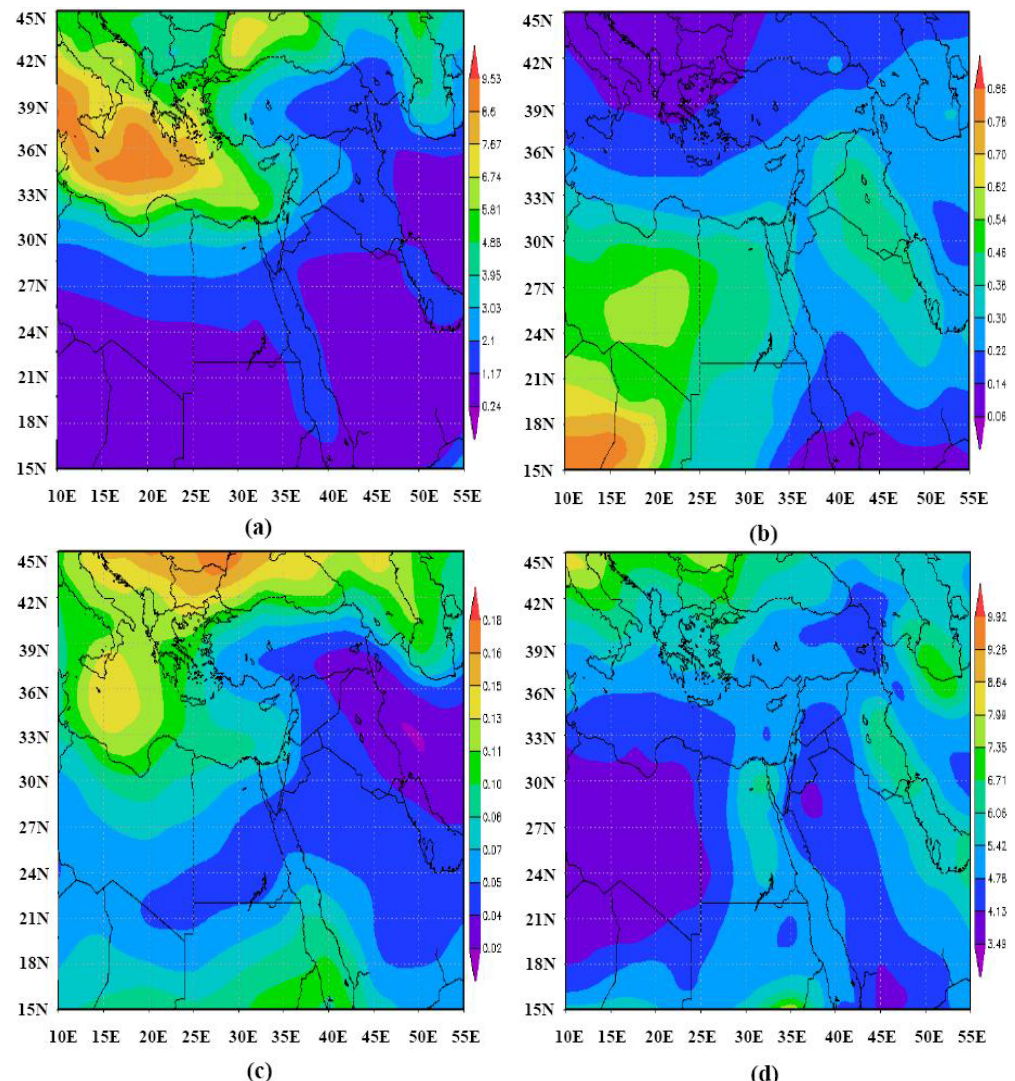
Fig. 5. GOCART model outputs of (a) sea salt in winter 2003, (b) dust in spring 2003, (c) sulfates in summer 2003, and (d) black carbon AOD in fall 2003 respectively showing potential sources and relative concentrations of these aerosol types over Alexandria and the Nile Delta